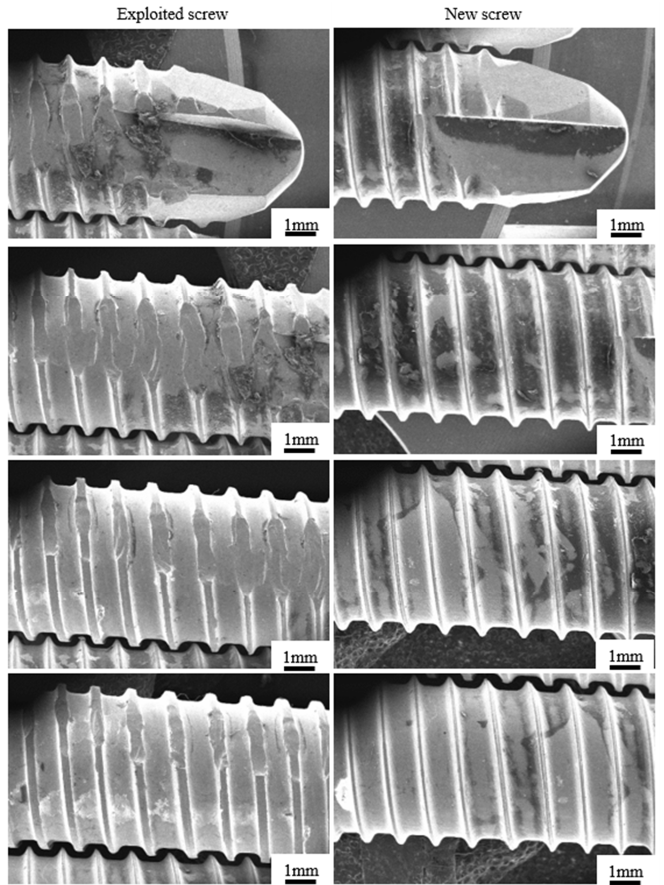
Figure 17. Comparison of the explanted screw (left column) and the new one (right column).